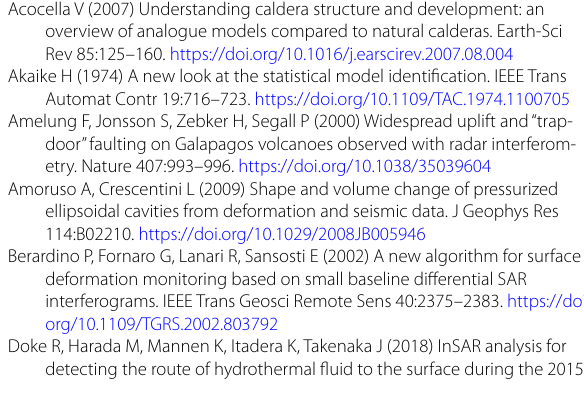
Figure S10. Data fitting using analytical solutions of the surface deforma- tion caused by both a plane dislocation and an isotropic deflation (Model C). Figure S11. Root-mean-square error (RMSE) distributions for a plane dislocation and an isotropic deflation in Model C. Figure S12. Data